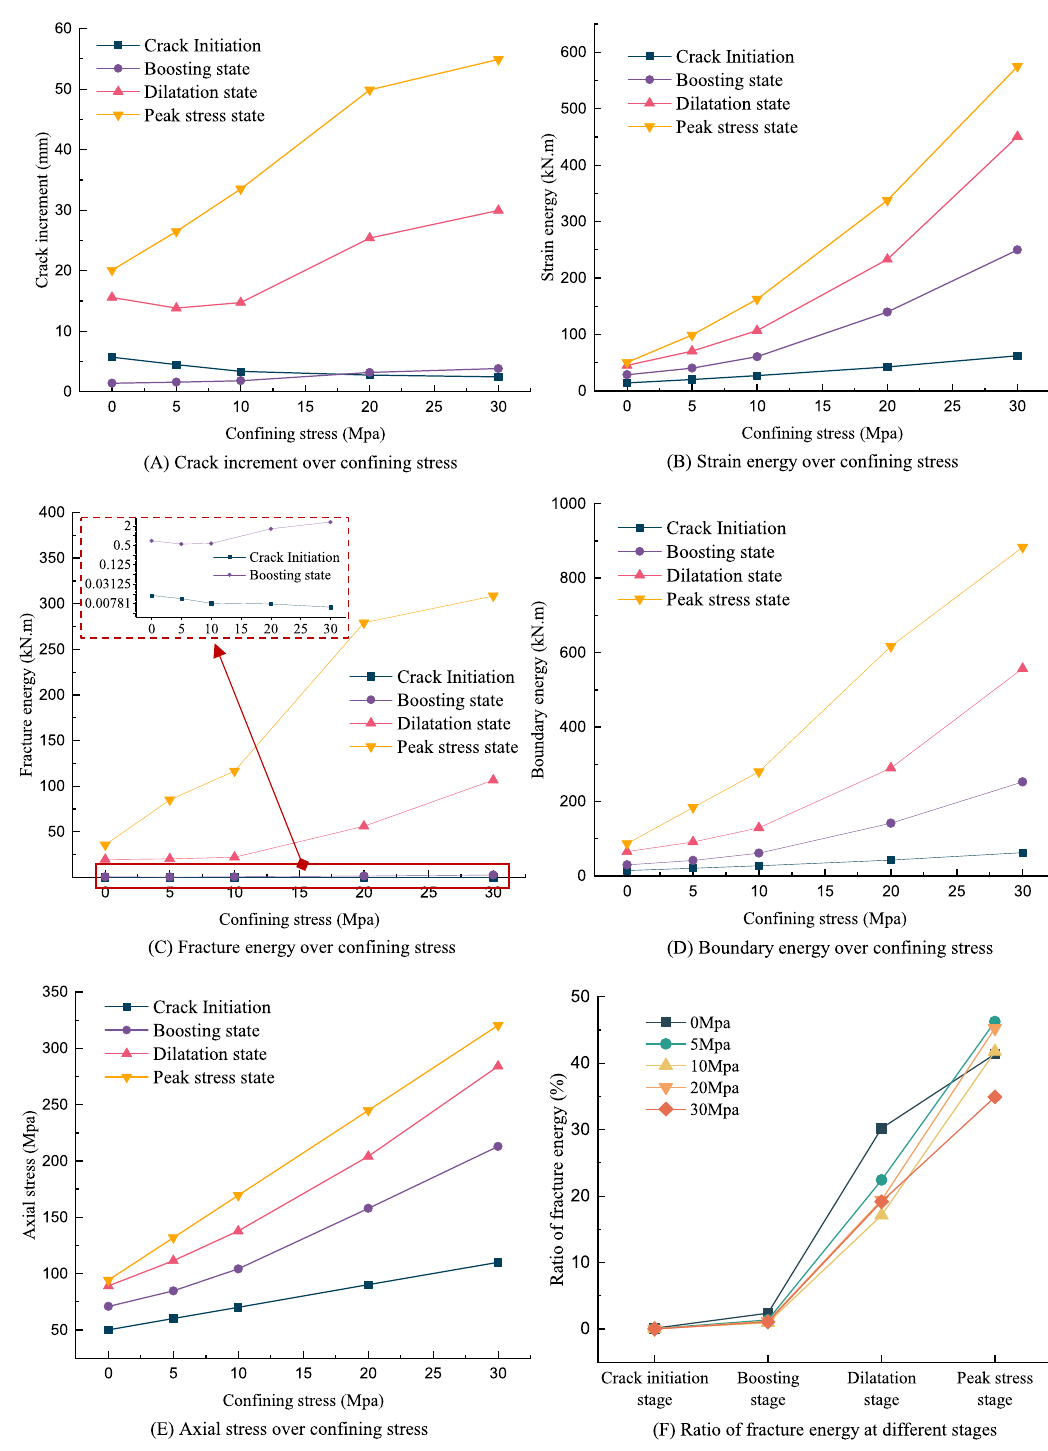
Figure 13. Comparison of key parameters over different confining